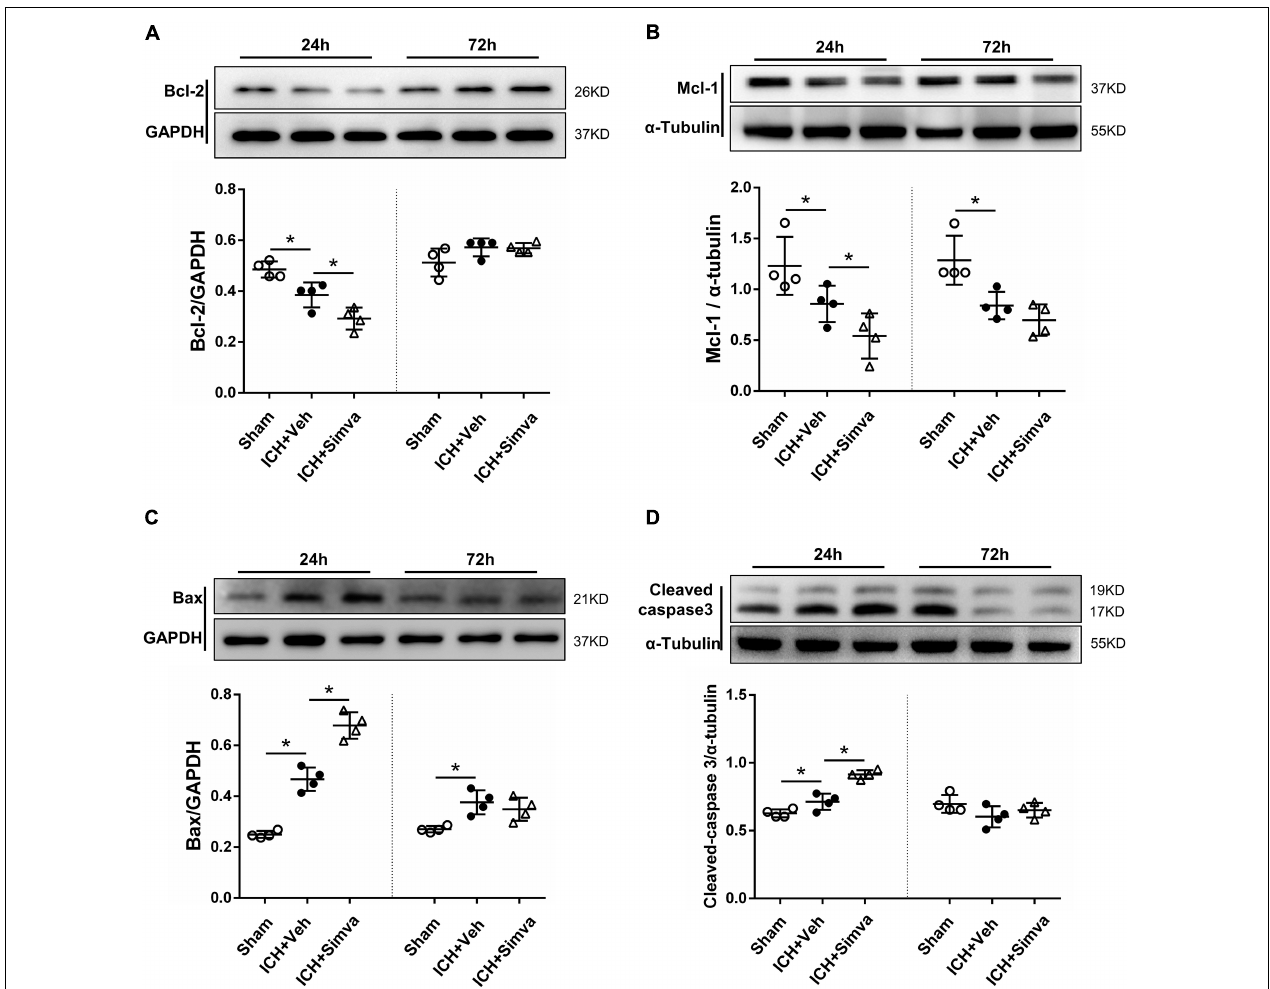
FIGURE 6 | Western blot analysis of the levels of apoptotic related proteins in PMNs after ICH. Representative images and quantitative analysis of Bcl-2 protein (A) , Mcl-1 protein (B) , Bax protein (C) , and caspase 3 protein (D) in the isolated peripheral PMNs at 24 h and day 3 after ICH. Values are expressed as mean ± SD, n = 4 per group; ∗ P < 0.05 versus sham